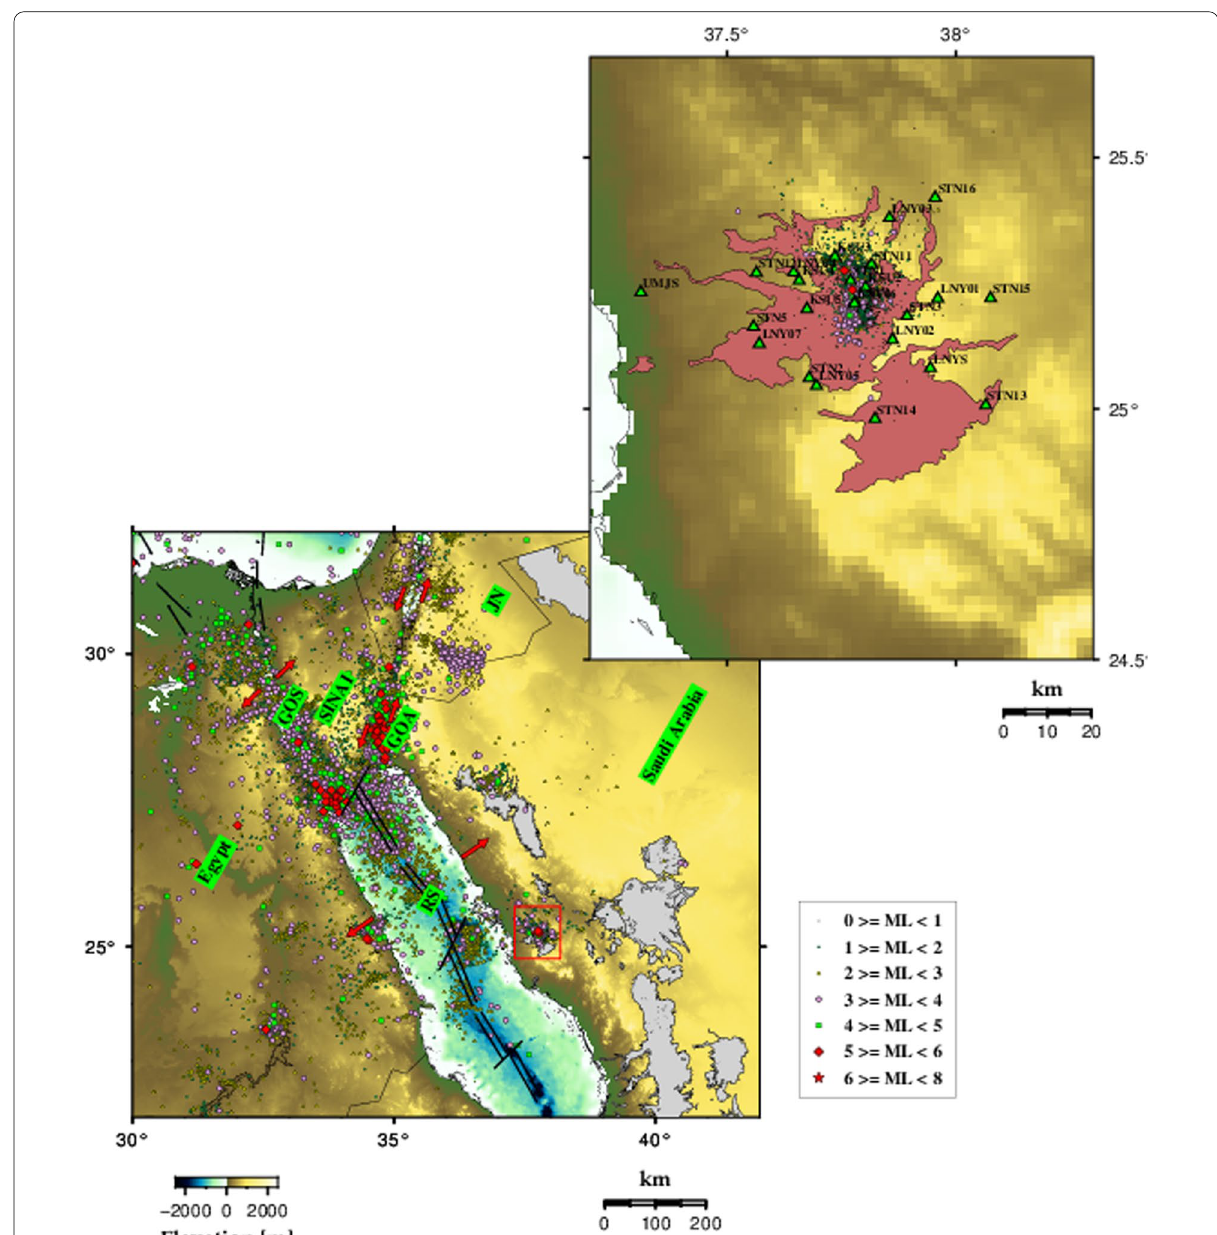
Fig. 1 The left panel shows the distribution of epicenters in the northernmost part of the Red Sea region. The map shows the random distribution of earthquake source zones in the Red Sea’s eastern and western flanks. The rectangular inset indicates the location of the HL area. The right panel shows the epicentral distributions of the 2009 earthquake swarm and the seismic stations. The polygon represents the Harrat